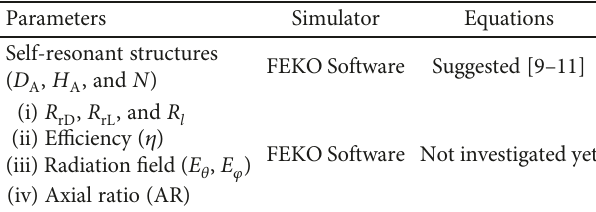
Table 1: Parameters for designing NMHA.